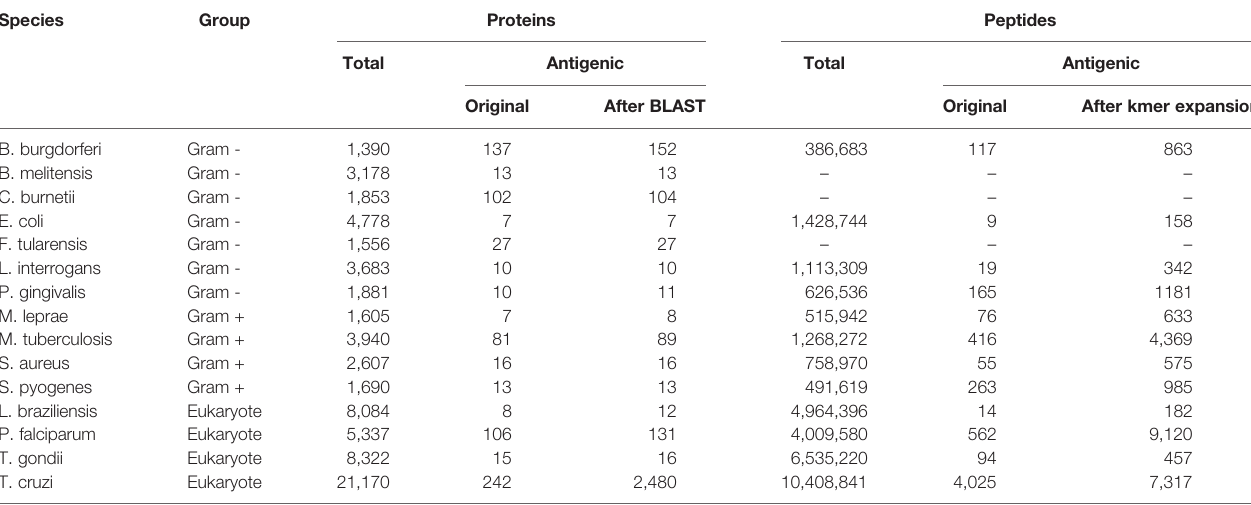
TABLE 3 | Amount of antigenic proteins and peptides for each